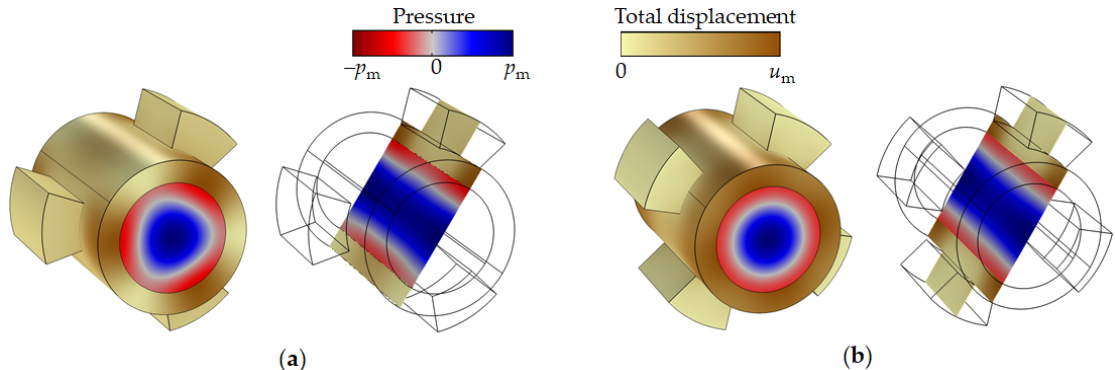
Figure 4. Unit cells of the tubular phononic crystal with a 3 ( a ) and 4 ( b ) ring segments: distribution of pressure and displacement fields. The radial mode was excited by applying a mechanical displacement to each sector along the normal of the cylinder surface.